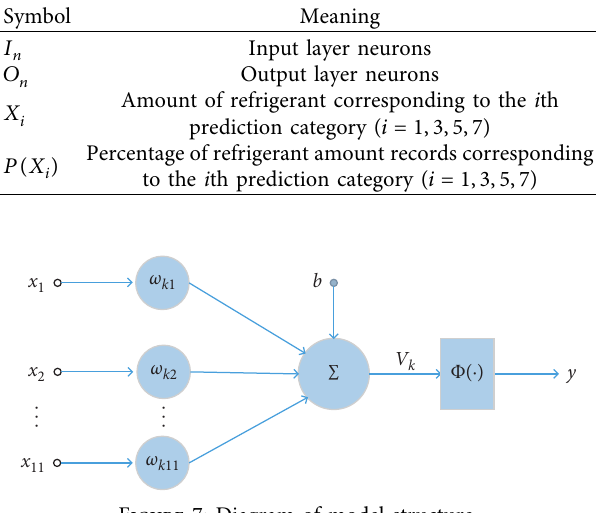
Figure 7: Diagram of model structure.